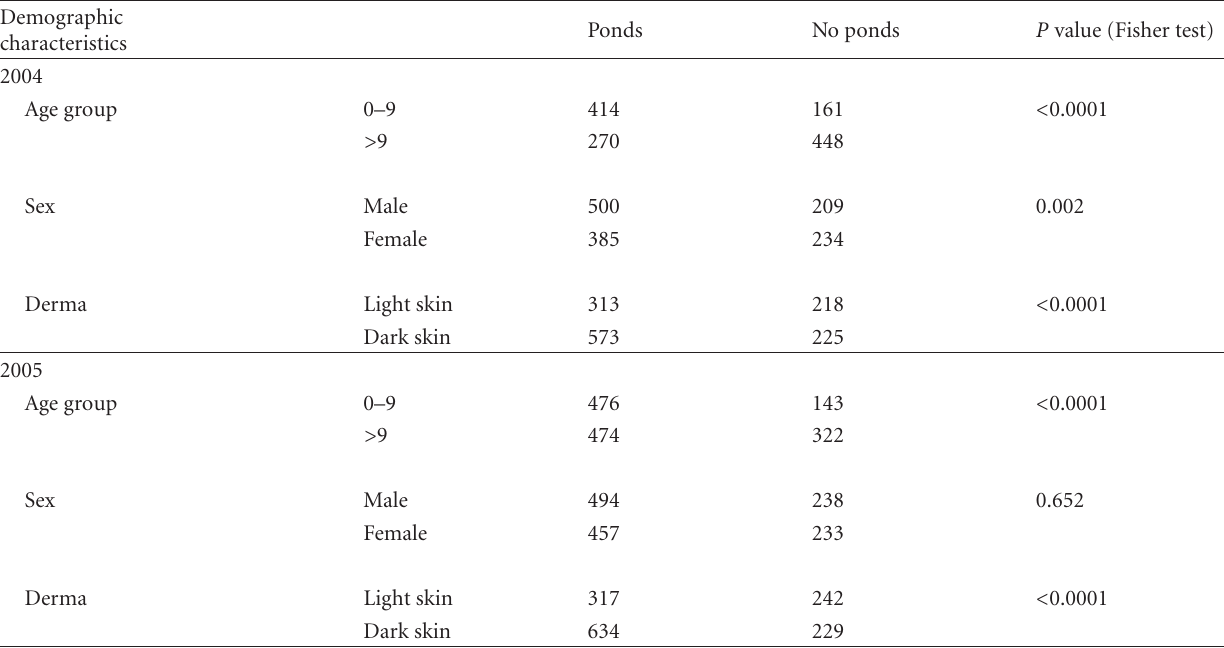
Table 2: Demographic characteristics of study